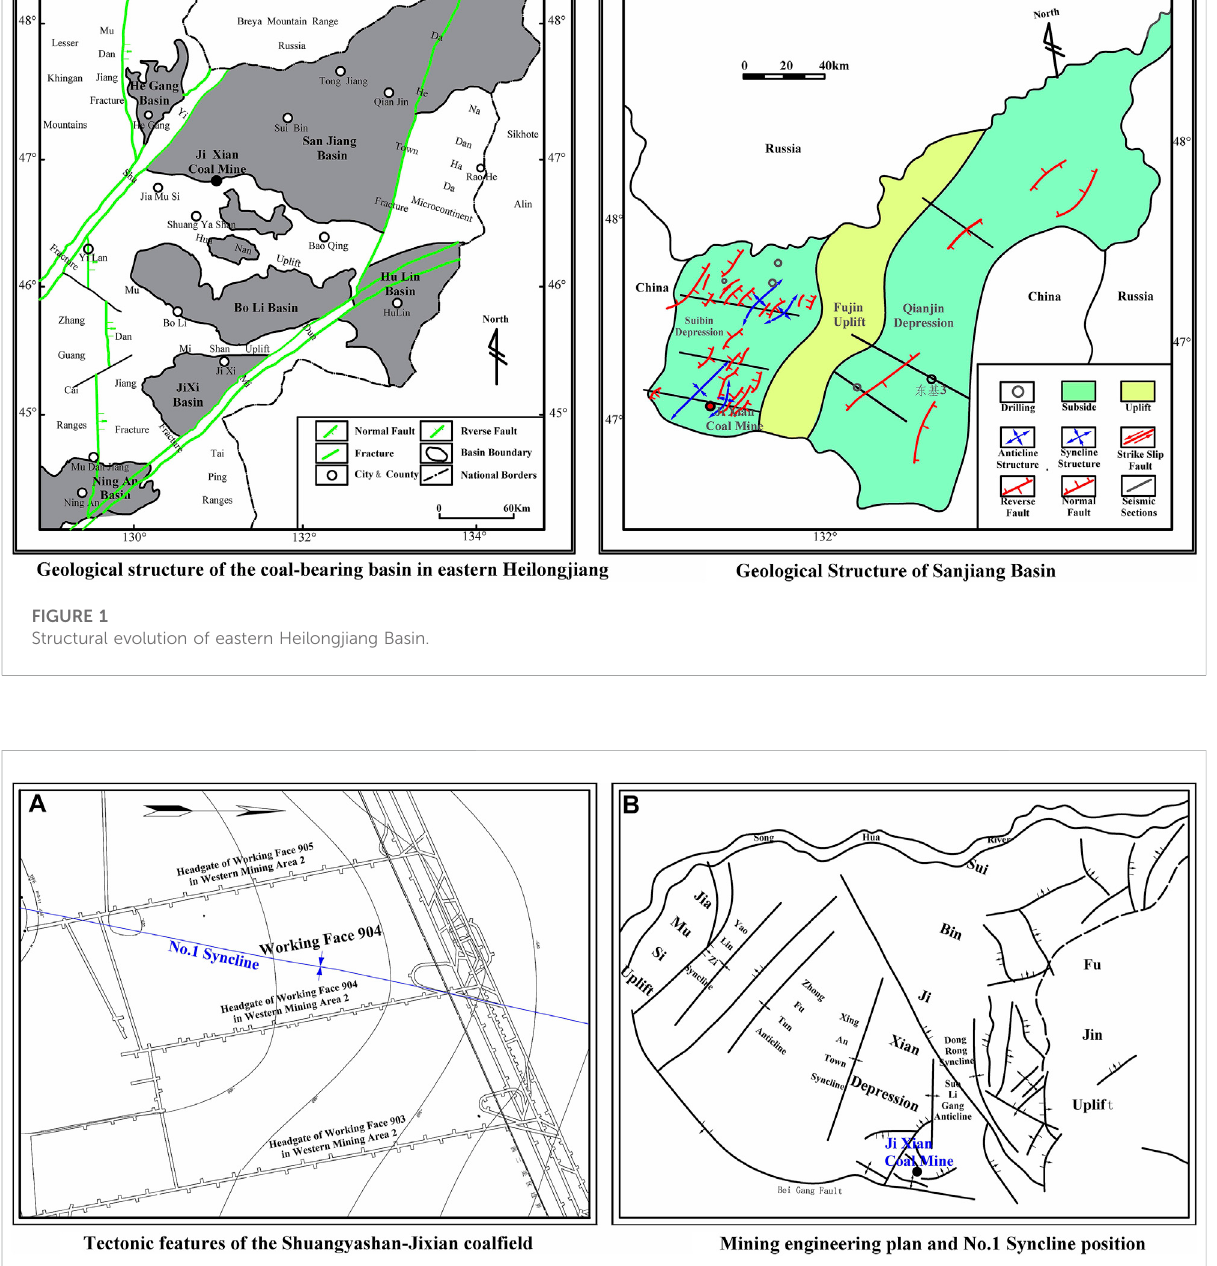
FIGURE 2 Structural features of Jixian Coal fi eld and mining engineering plan of study